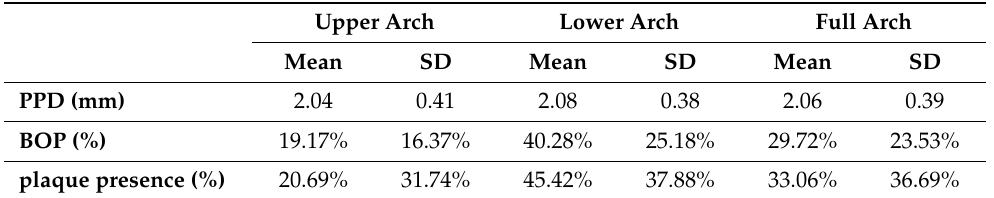
Table 6. Periodontal parameters at